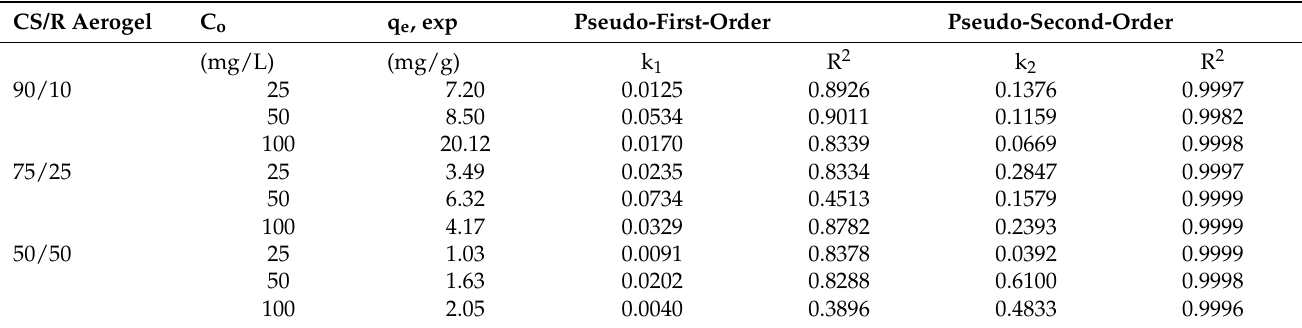
Table 5. Kinetic parameters of Cr (VI) adsorption at different initial concentrations and CS/R aerogel ratios.